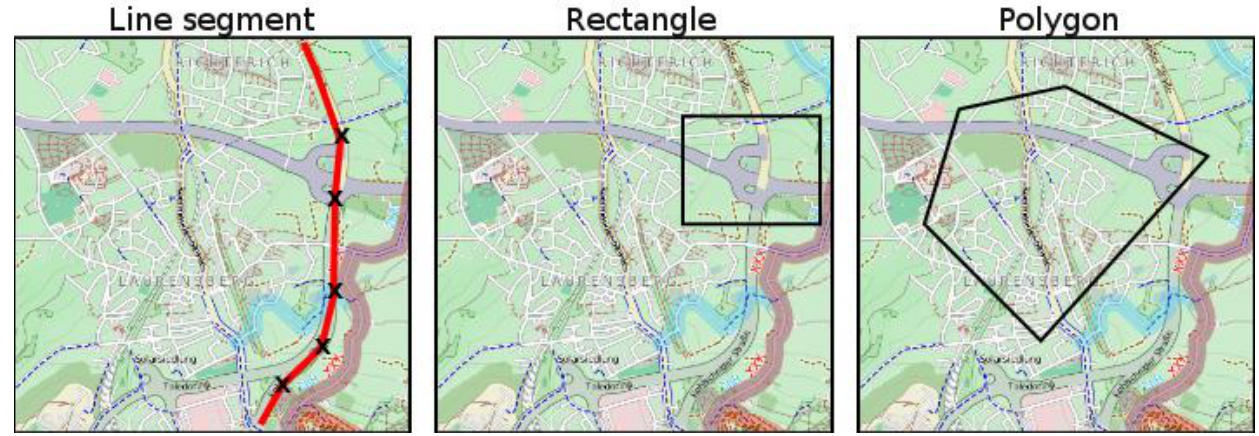
Figure 2. Spatial filters, ( left ) a line segment filter, ( center ) a rectangle filter, and ( right ) an orthogonal polygonal